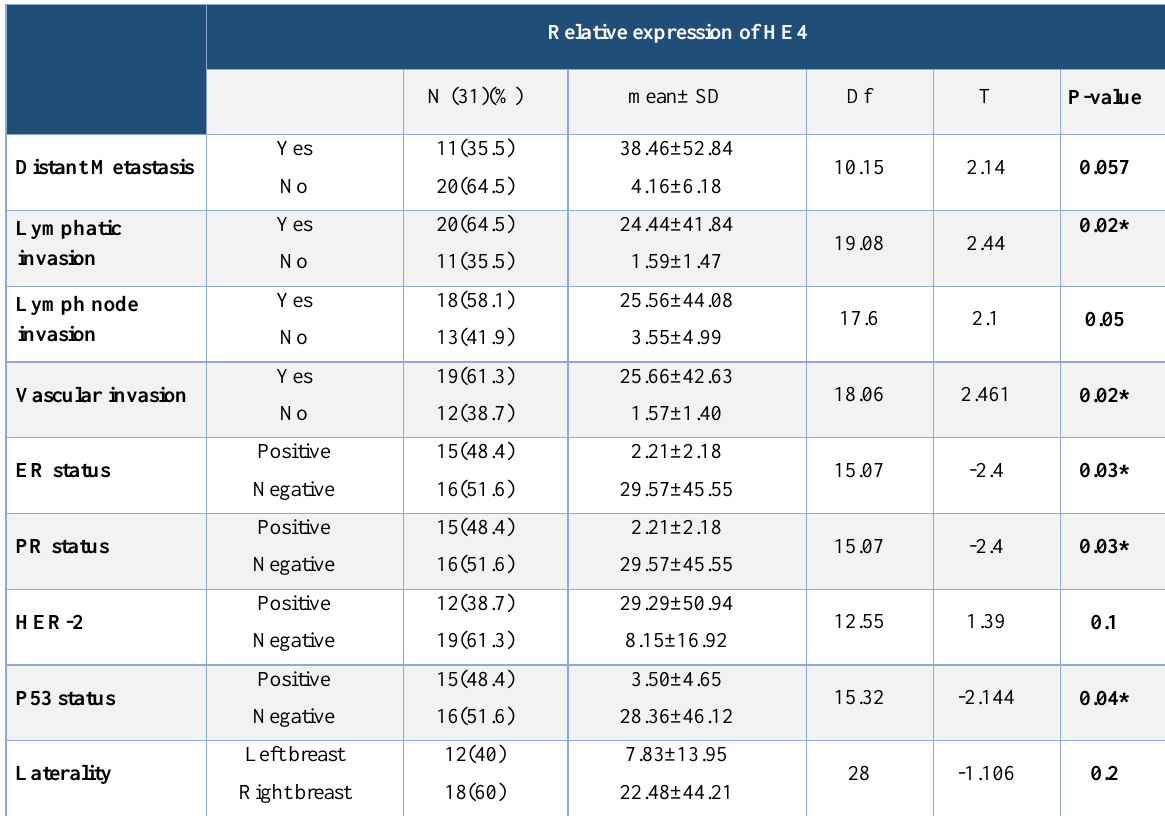
Table 5. Association between HE4 relative expression in BCT samples and occurrence of metastases, HR status, HER2 expression, and P53 mutation status. Results of parametric independent T-test.